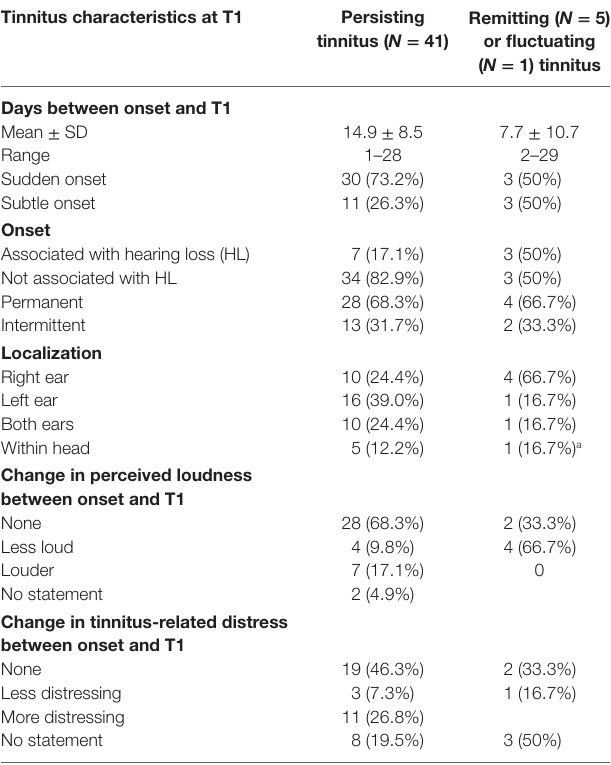
TaBle 3 | Comparison of tinnitus characteristics between groups with persisting and remitting tinnitus. Tinnitus characteristics at